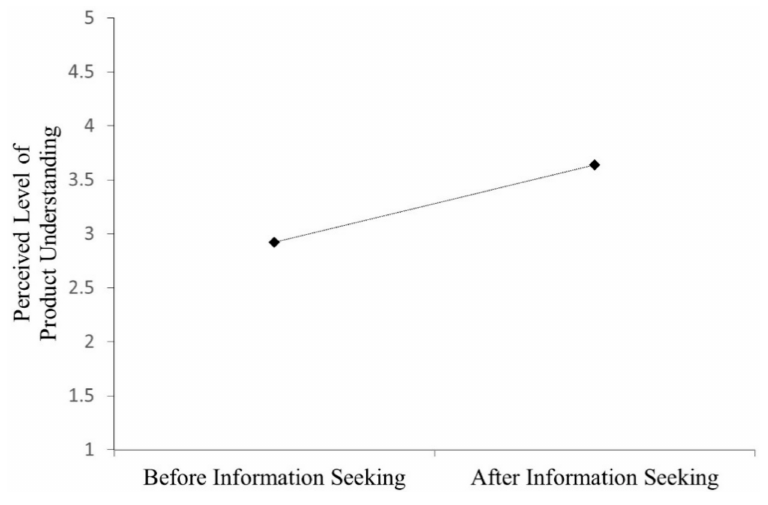
Figure 2. Perceived level of product